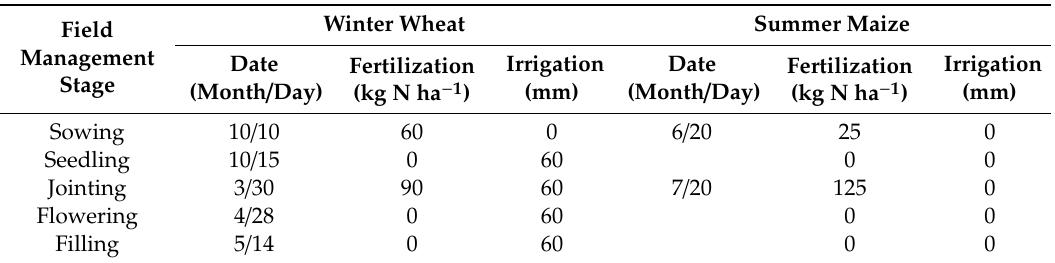
Table 1. Sowing date and optimized field management measures of winter wheat and summer maize.